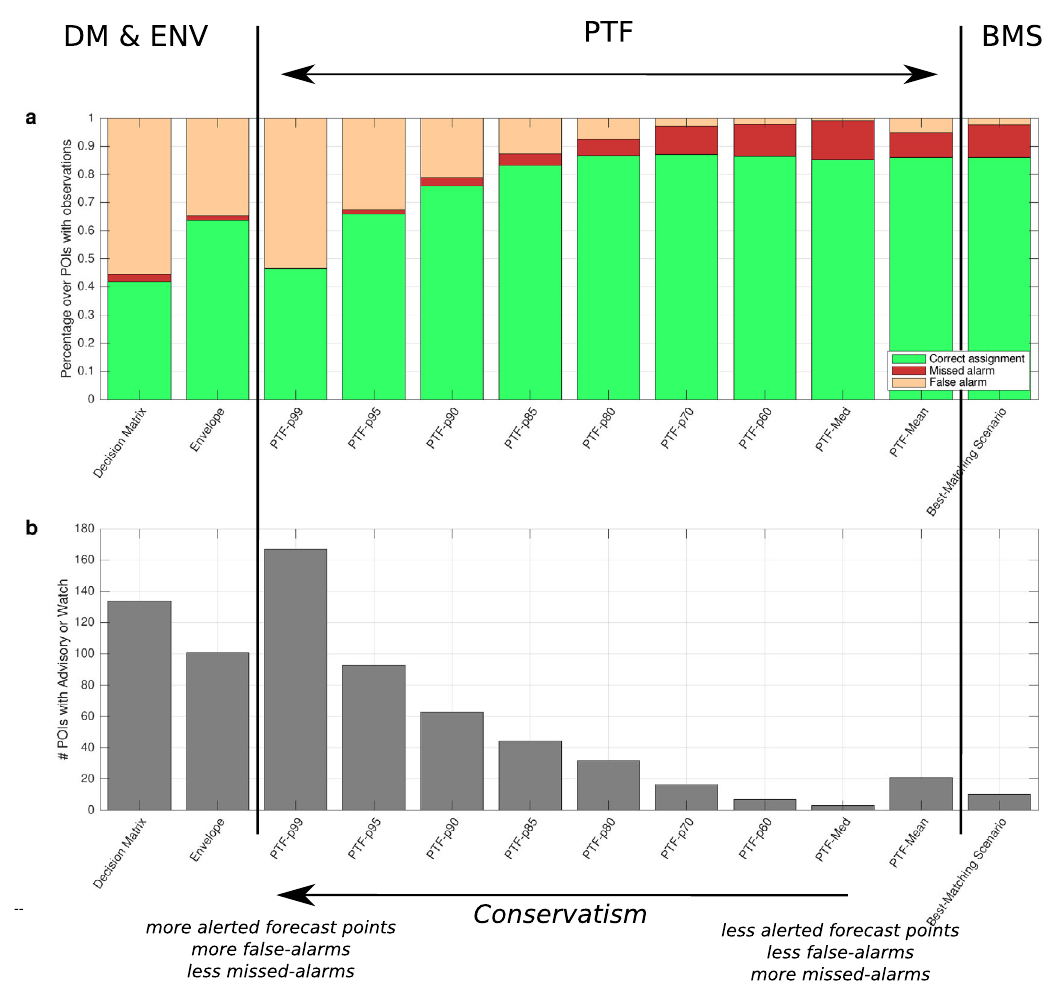
Fig. 6 Alert levels from PTF and non-probabilistic methods. We compare the assigned and observed alert levels based on DM, ENV, BMS, and PTF statistics for the 13 events in the testing dataset considered in this paper (Fig. 5a). a Average percentage of correct- (green), false- (yellow) and missed alarms (red) at forecast points with observations. b Average total number of forecast points with advisory and watch levels at all forecast points. Note that CAT-INGV DM is less conservative than the original NEAMTWS DM. The different PTF statistics allow covering the full range of conservative choices, encompassing the range de fi ned by existing non-probabilistic methods. The selection of a speci fi c PTF percentile can be explicitly linked to a pre-de fi ned level of conservatism, quantifying the expected rate of false/missed